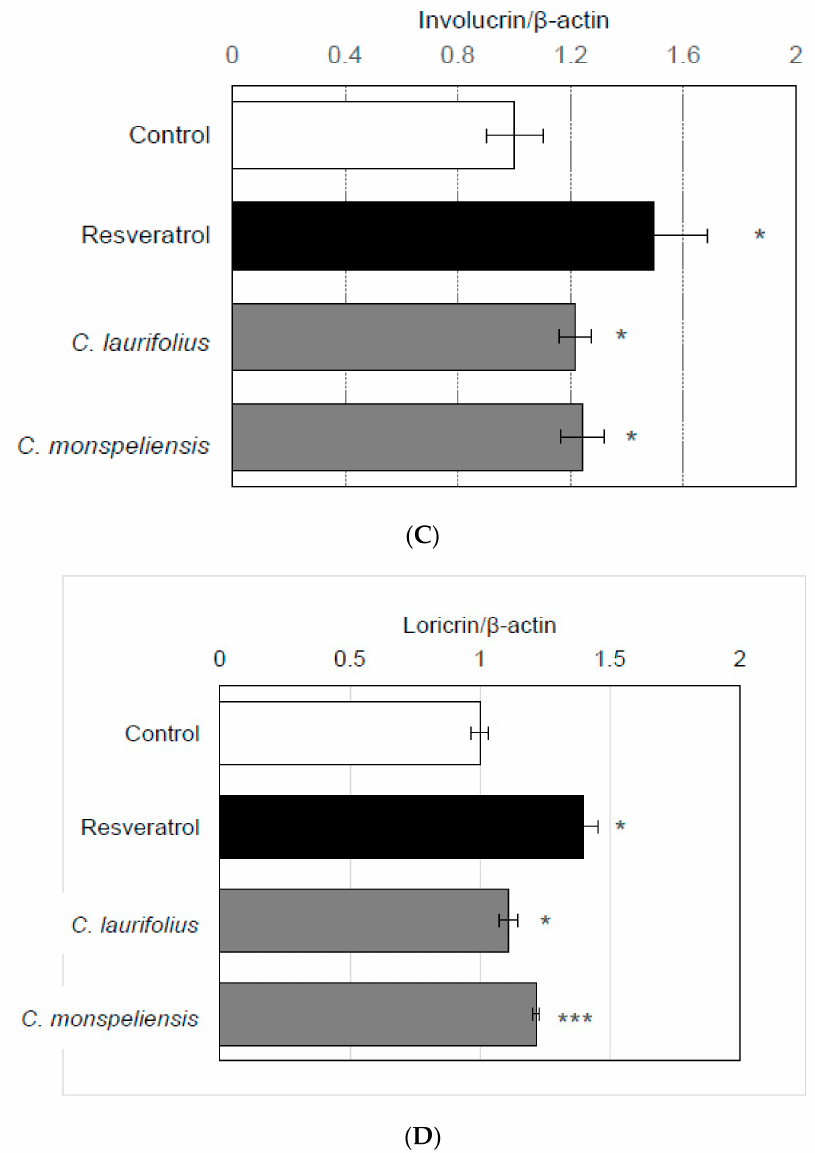
Figure 2. Effects of essential oils on HaCaT cells. ( A ) The effects of essential oils (final concentration: 100 ng/mL) on the expression of PGC-1 α in HaCaT cells were evaluated by qRT-PCR. ( B ) The effects of essential oils (final concentration: 100 ng/mL) on the copy number of mitochondria DNA in HaCaT cells were evaluated by qPCR. ( C , D ) The effects of essential oils (final concentration: 100 ng/mL) on the expression of involucrin and loricrin in HaCaT cells were evaluated by qRT-PCR. Statistical significance was determined by using a two-sided Student’s t -test. Statistical significance was evaluated by comparison with the control and defined as p < 0.05 (* p < 0.05; *** p < 0.001). Values are means ± SEM ( n = 3). As a control treatment, HaCaT cells were treated with